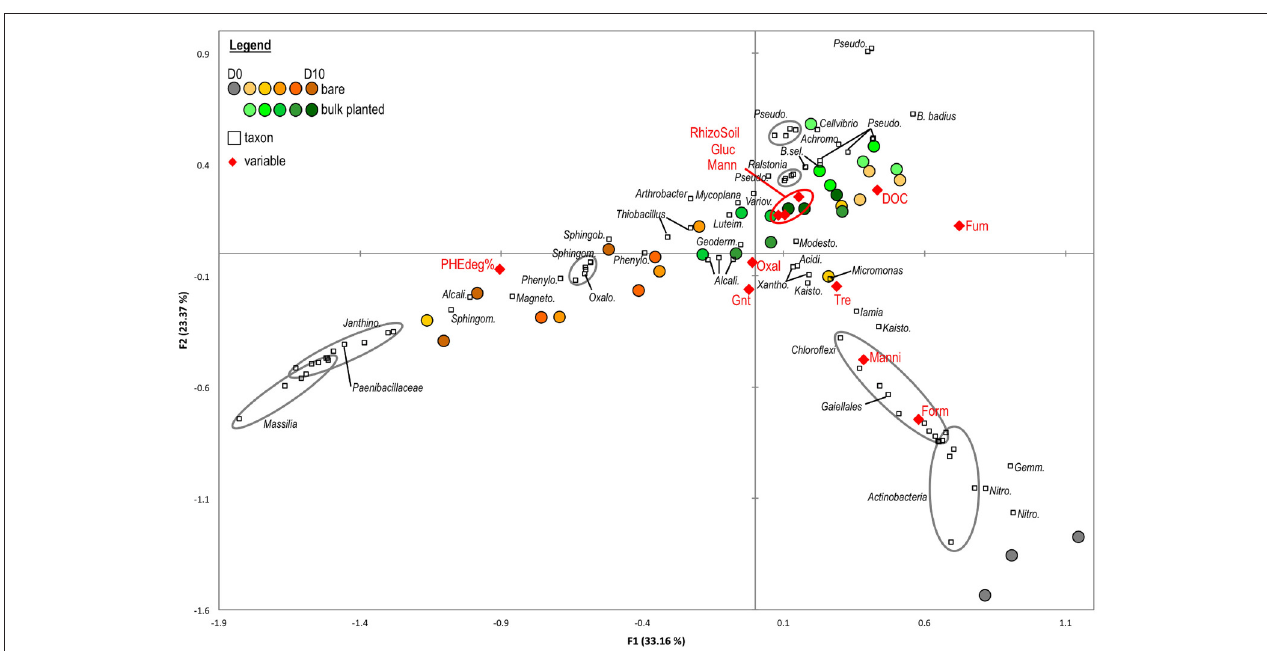
FIGURE 5 | Canonical Correspondance Analysis based on the distribution of abundant OTUs ( > 1% in at least one sample) in cDNA libraries. The model accounted for 61.6% of the total inertia, with a global P -value < 0.0001. Circles represent samples from bare (green palette) or bulk planted soil (orange palette). Environmental variables (red diamonds) include percentage of PHE degradation (PHEdeg%), rhizospheric soil fresh weight (RhizoSoil), total dissolved organic carbon (DOC), glucose (Gluc), mannose (Mann), trehalose (Tre), mannitol (Manni), fumarate (Fum), oxalate (Oxal), gluconate (Gnt), and formate (Form). Squares represent OTUs with their taxonomic affiliation, abbreviated as follows: Janthino ., Janthinobacterium ; Sphingom ., Sphingomonas ; Alcali ., unclassified Alcaligenaceae ; Magneto ., Magnetospirillum ; Phenylo ., Phenlyobacterium ; Oxalo ., unclassified Oxalobacteraceae ; Sphingob ., Sphingobium ; Geoderm ., unclassified Geodermatophilaceae ; Luteim ., Luteiomas ; Variov ., Variovorax ; Pseudo ., Pseudomonas ; B. sel ., Bacillus selenatarsenatis ; Achromo. , Achromobacter ; B. badius , Bacillus badius ; Modesto ., Modestobacter ; Acidi ., unclassified Acidimicrobiales ; Xantho ., unclassified Xanthomonadaceae ; Kaisto ., Kaistobacter ; Nitro ., Nitrospira ; Gemm ., Gemmatimonadetes . For clarity, only OTUs with contribution > 1% to at least one axis were